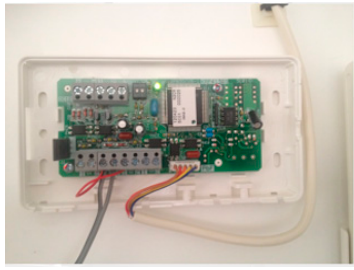
Figure 11. Silicone DC relays.